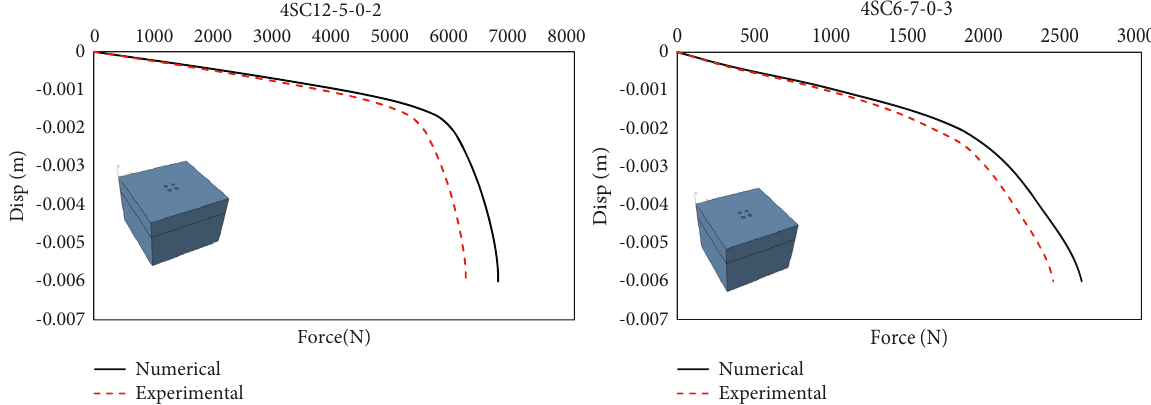
Figure 9: Force-displacement diagram related to models 4SC6-7-0-3 and 4SC12-5-0-2 in both numerical and laboratory modes. Table 5: Numerical comparison of bearing capacity of numerical and laboratory models related to reinforced sandy soil samples. Model